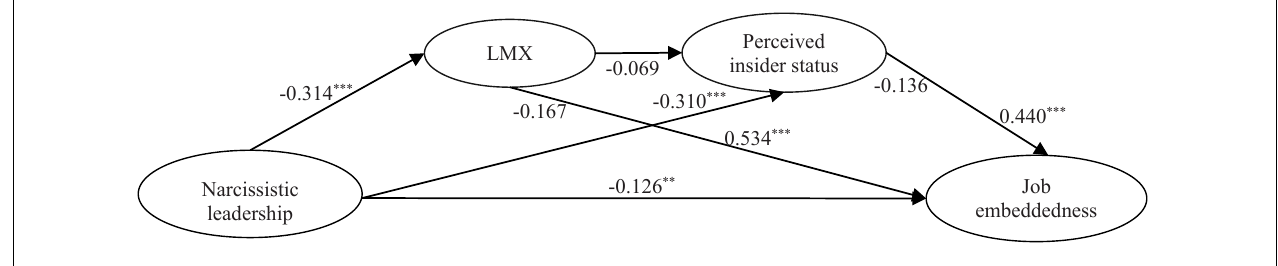
FIGURE 2 | Estimated model. *** p < 0.001, ** p < 0.01, * p <